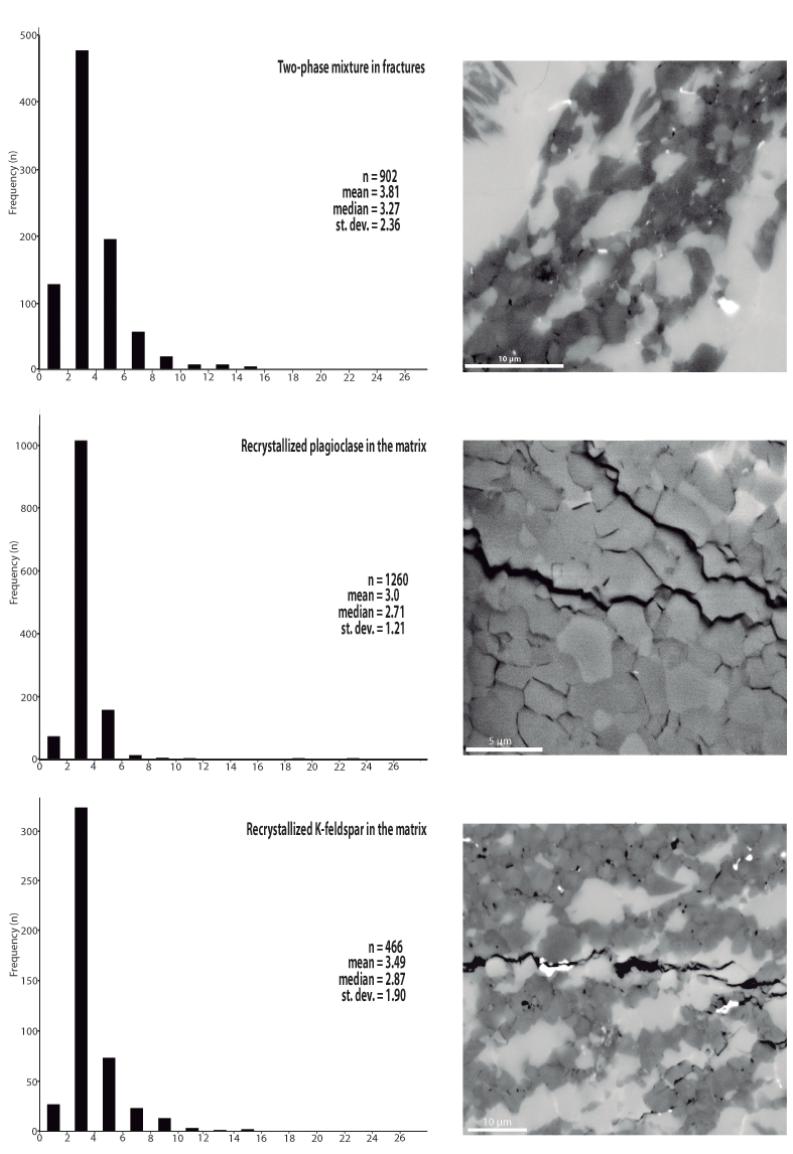
Figure 7. Grain-size histograms for recrystallized feldspars as mixtures in the fractures and as individual phases in the matrix.